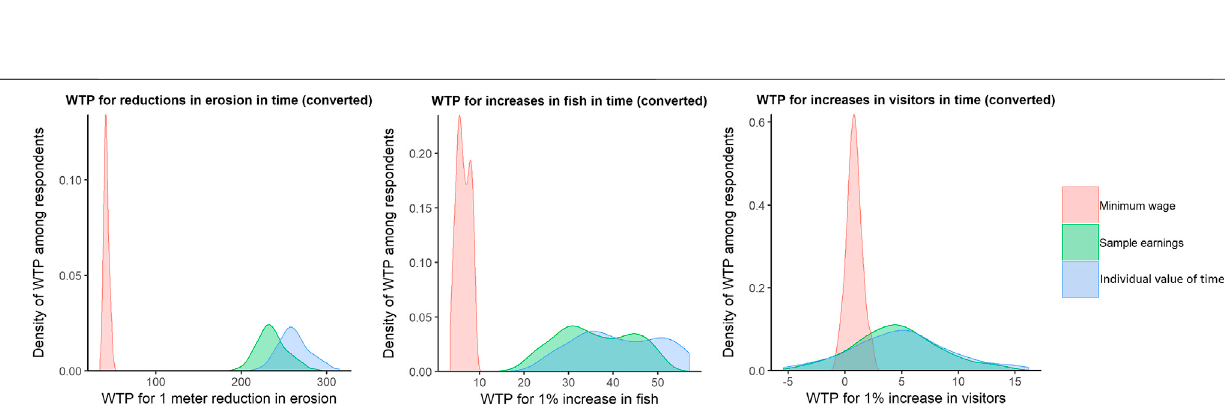
FIGURE 7 | Urban willingness to pay (WTP) distributions for time (converted) payments for the three attributes “ erosion control ” (left) , “ fi sh abundance ” (middle) and “ visitors ” (right) .